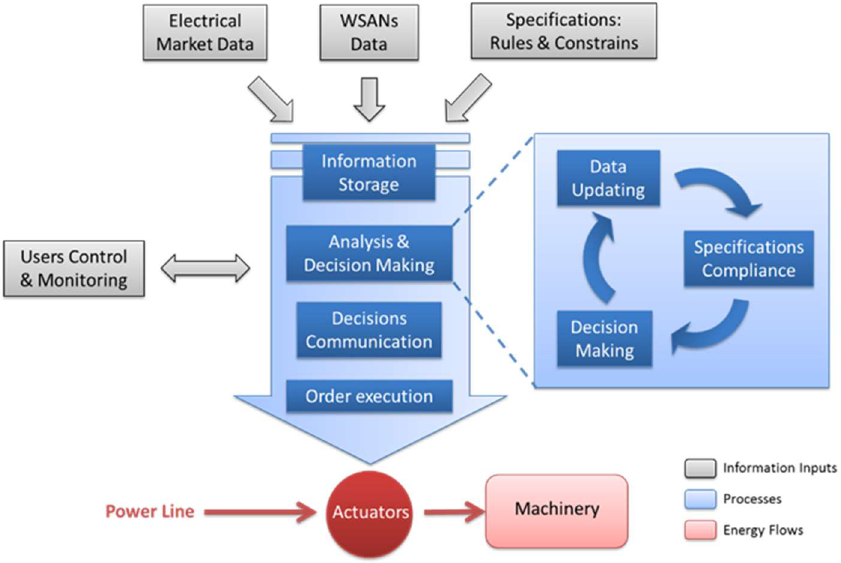
Figure 8. Logical architecture of the system.